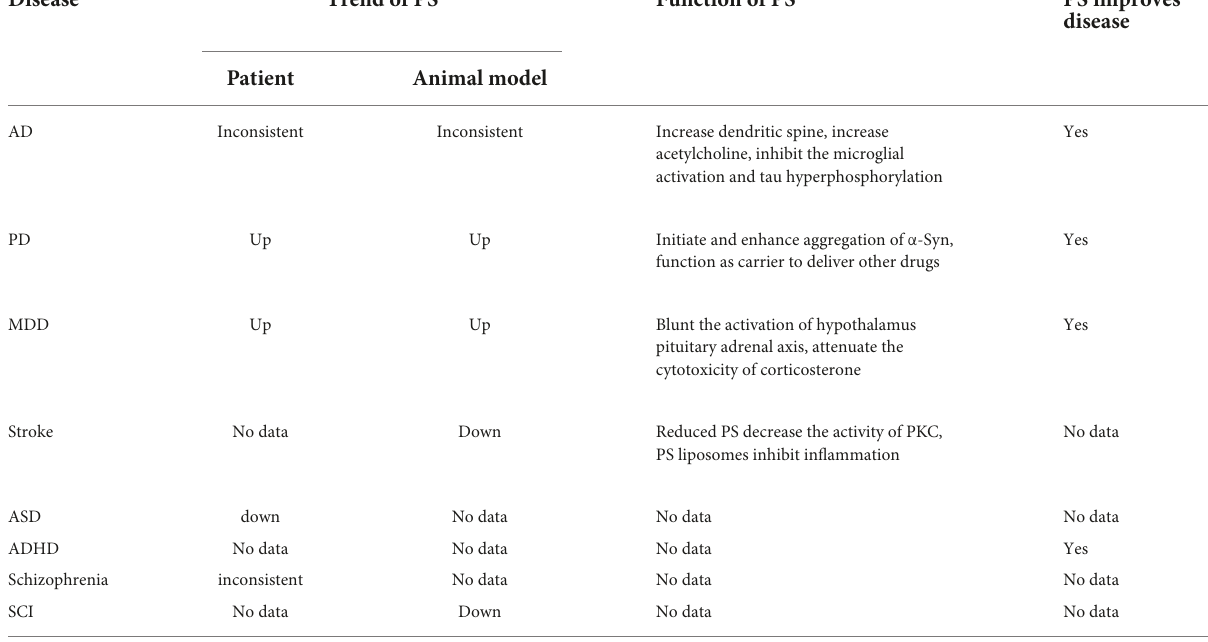
TABLE 4 The trend and function of phosphatidylserine (PS) in central nervous system (CNS) disease.